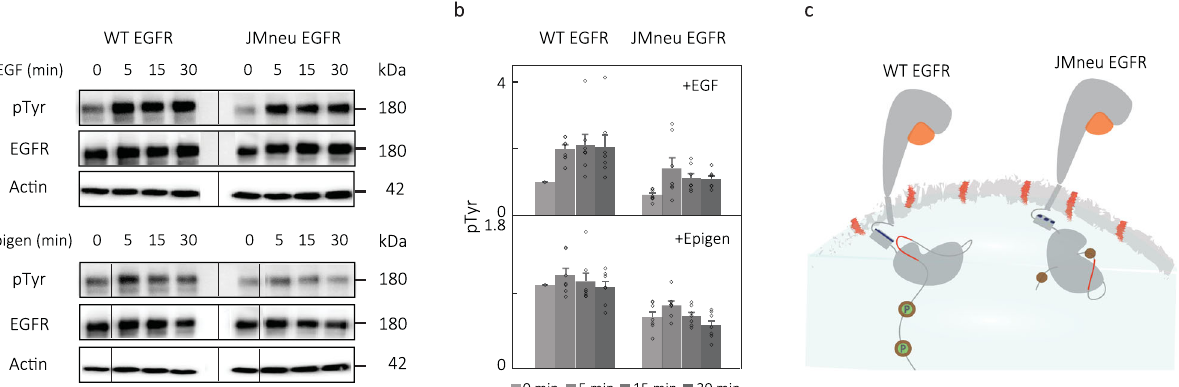
Fig. 5 Cellular experiments with JMneu EGFR show reduced phosphorylation. a Expression of phosphorylated EGFR and total EGFR at 0, 5, 15, and 30 min of 100 ng/mL EGF (top) and 300 ng/mL of epigen (bottom) stimulation in CHO cells transfected with WT EGFR and JMneu EGFR. Actin was used as a loading control. The blots reported are representative of seven independent biological replicates. Black line delineates boundary between gels. b Relative expression of phosphorylated tyrosine (pTyr) was determined by western blot quanti fi cation. The values were normalized to pTyr before EGF or epigen stimulation (time 0) of the wild-type EGFR transfected cells. Data are presented as mean values + / − SEM from seven independent biological replicates (circles); average, SEM reported in Supplementary Table 6. Two-tailed, nonparametric, paired t-test was performed to obtain the P -values (exact P -values mentioned in Supplementary Table 7). No adjustments were made for multiple comparisons. Source data are provided as a Source data fi le. c Schematic of proposed effect of JMneu EGFR on phosphorylation in CHO cells. The positive region in the JMD is shown in blue in WT EGFR and in dotted blue in JMneu EGFR. The negative lipids and region in the NCTT are shown in red. The circles in the CTT indicate tyrosine phosphorylation (P)